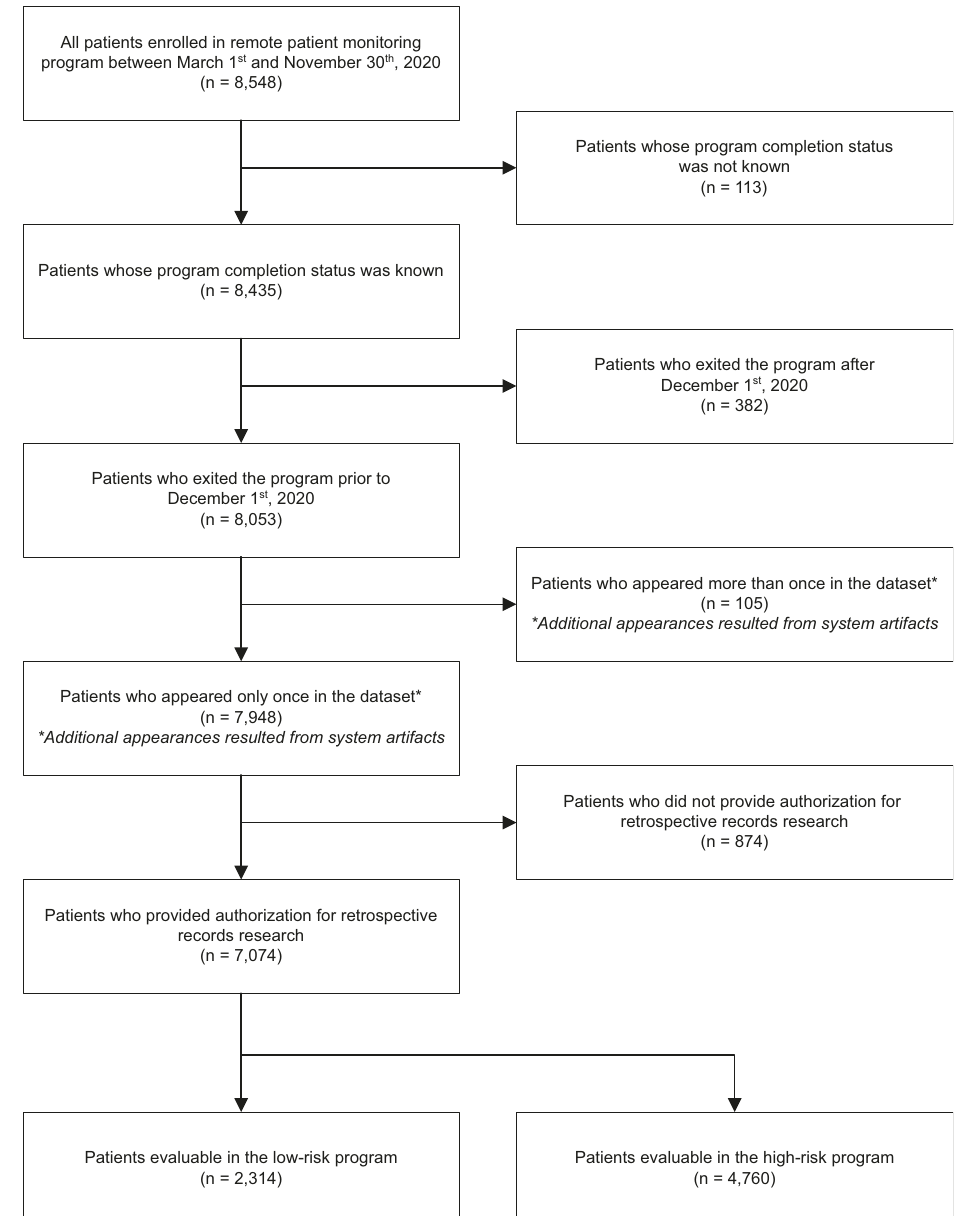
Fig. 2 Patient fl ow diagram for the RPM program. Patient enrollment, disposition, and authorization for retrospective record research for the fi nal